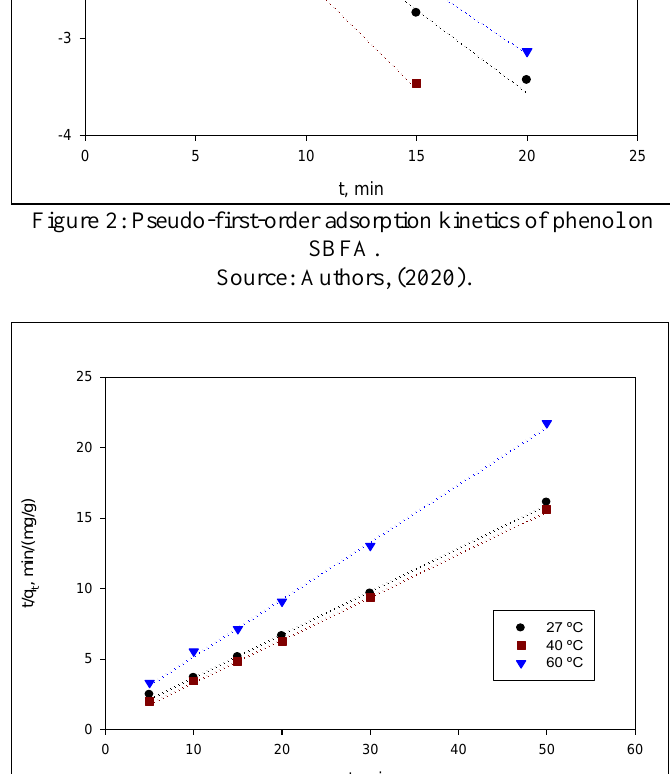
Figure 3: Pseudo-second-order adsorption kinetics of phenol on